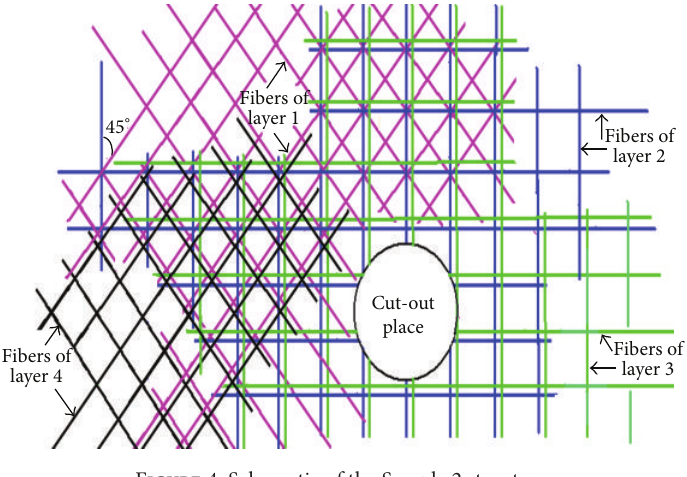
Figure 4: Schematic of the Sample 2 structure.